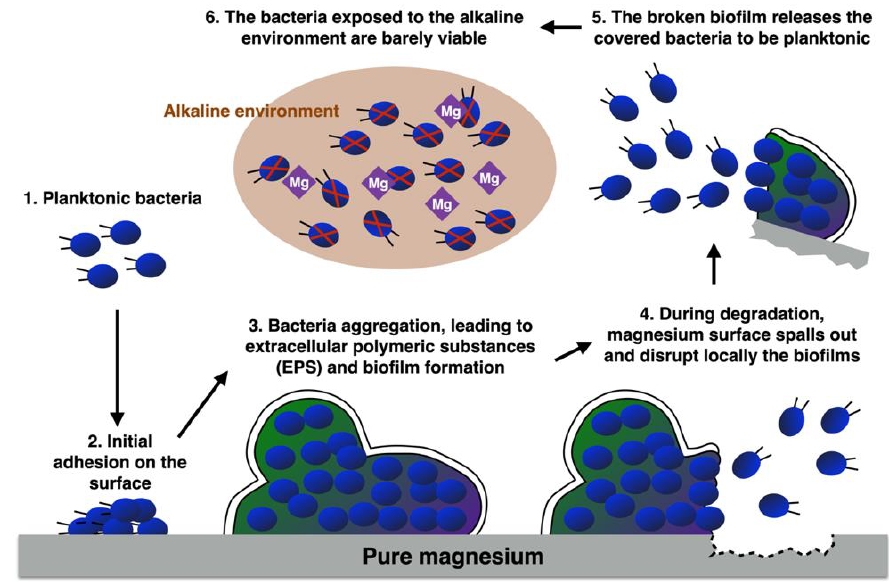
Figure 1. Schematic reaction of bacterial biofilm formation to the degradable Mg.